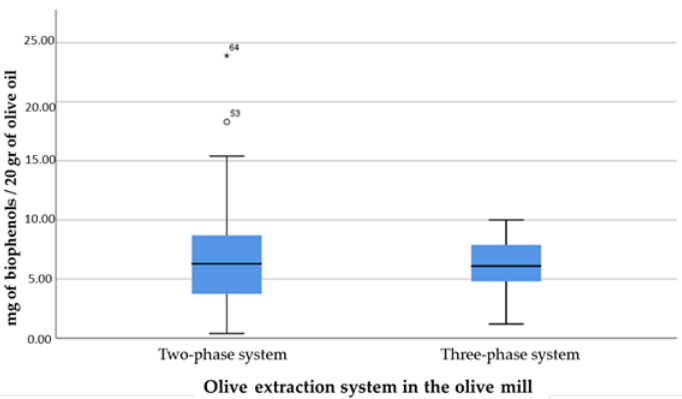
Figure 3. Comparison of biophenol concentrations with the extraction system in the mill.